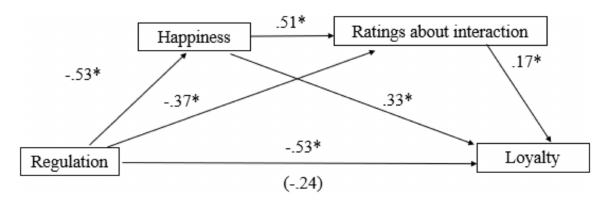
FIGURE 2 | Interpersonal emotion regulation increases loyalty through changing emotional responses toward the service interaction in Study 1. ∗ p < 0.05 (Value in parentheses indicates the effect of emotion regulation on the dependent variable after controlling for the